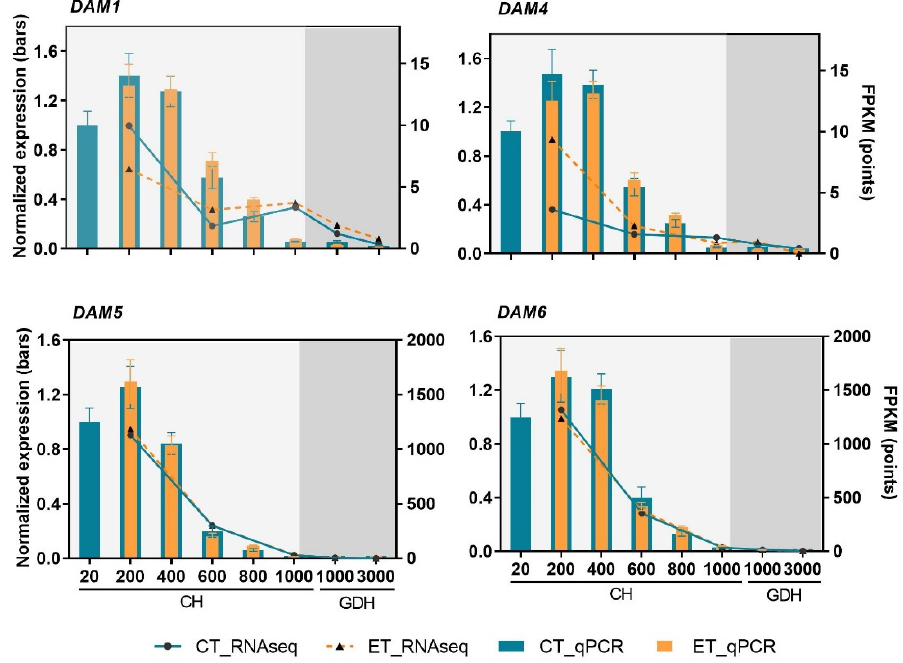
Figure 9. Expression profiles of DAM genes represented as FPKM values (points) and validation using RT-qPCR expression (bars), in which each datapoint represents the mean ± SE of three biological replicates, each with two technical replicates.